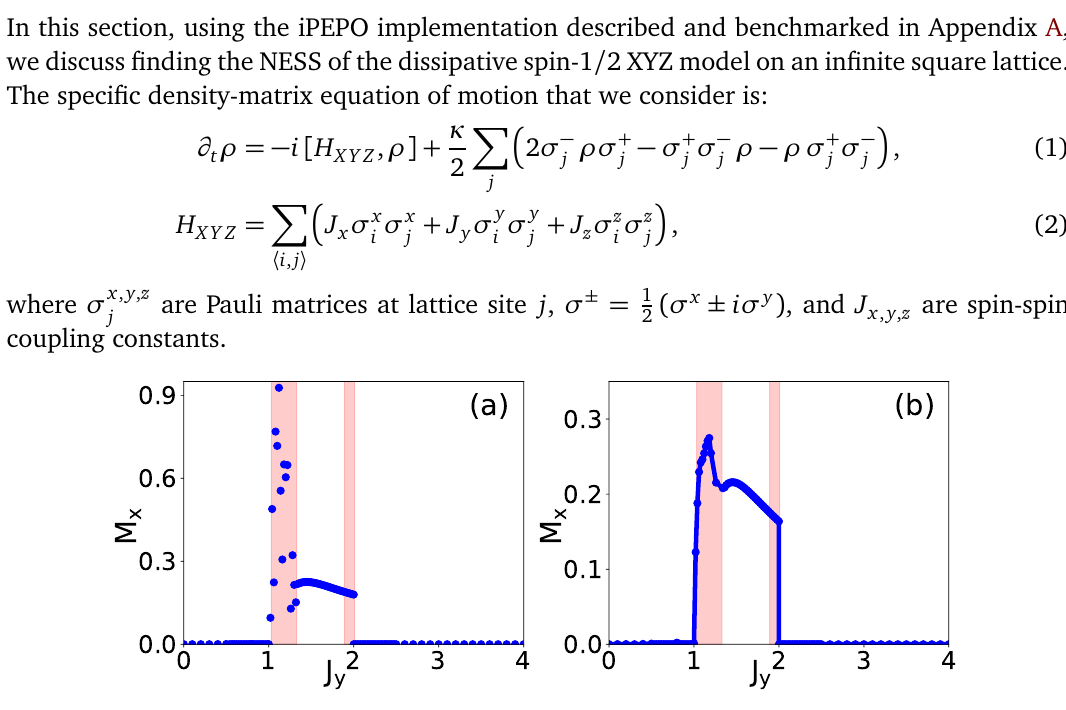
Figure 1: The magnetization order parameter M of the dissipative XYZ model as a x = 0.5, J = 1 and D = 4. Energies given function of coupling strength J , for J y x z in units of κ = 1. The red highlighted areas indicate parameter regimes where the iPEPO algorithm fails to reach a steady state. (a) Results computed using timesteps δ t = 10 − 1 ,10 − 2 run until a steady state is found. (In the red regions, the run is stopped after N = 1000 steps with δ t = 10 − 1 followed by N = 2000 steps with δ t = 10 − 2 .) (b) Results calculated using a large timestep δ t = 10 − 1 and stopping after N = 1000